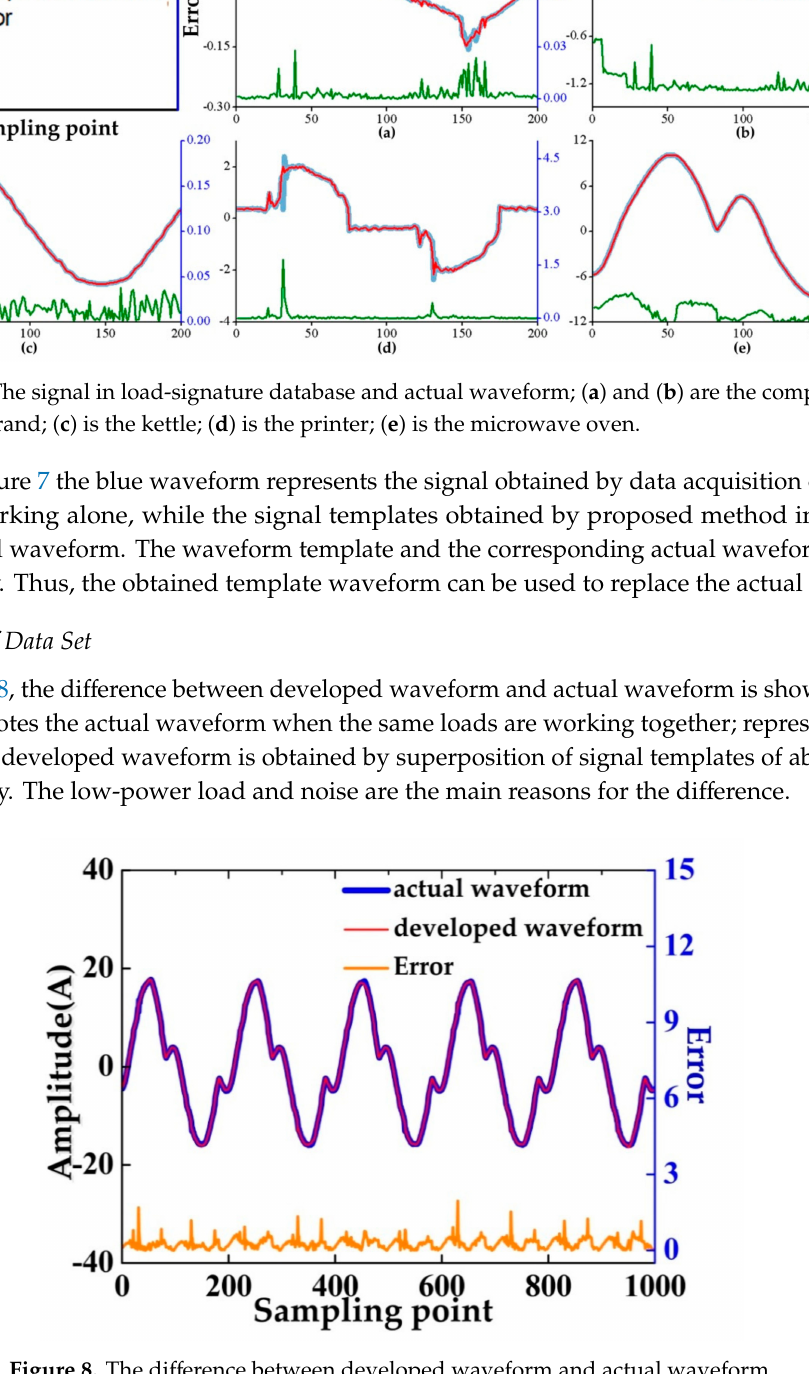
Figure 8. The di ff erence between developed waveform and actual